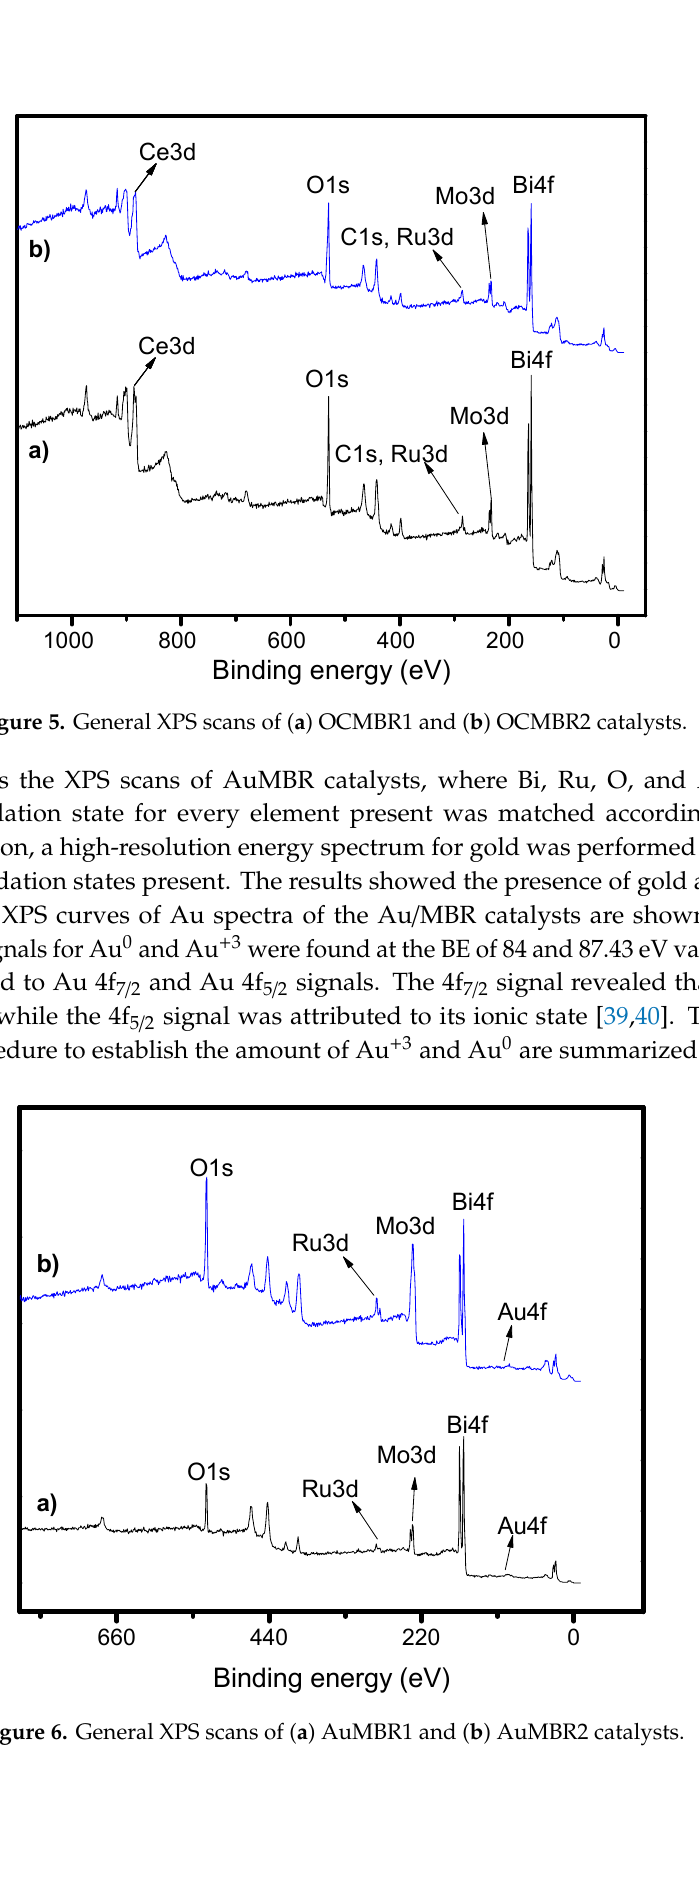
Figure 4. High-resolution XPS analysis for Ru3d of ( a ) MBR1 and ( b ) MBR2 supports.